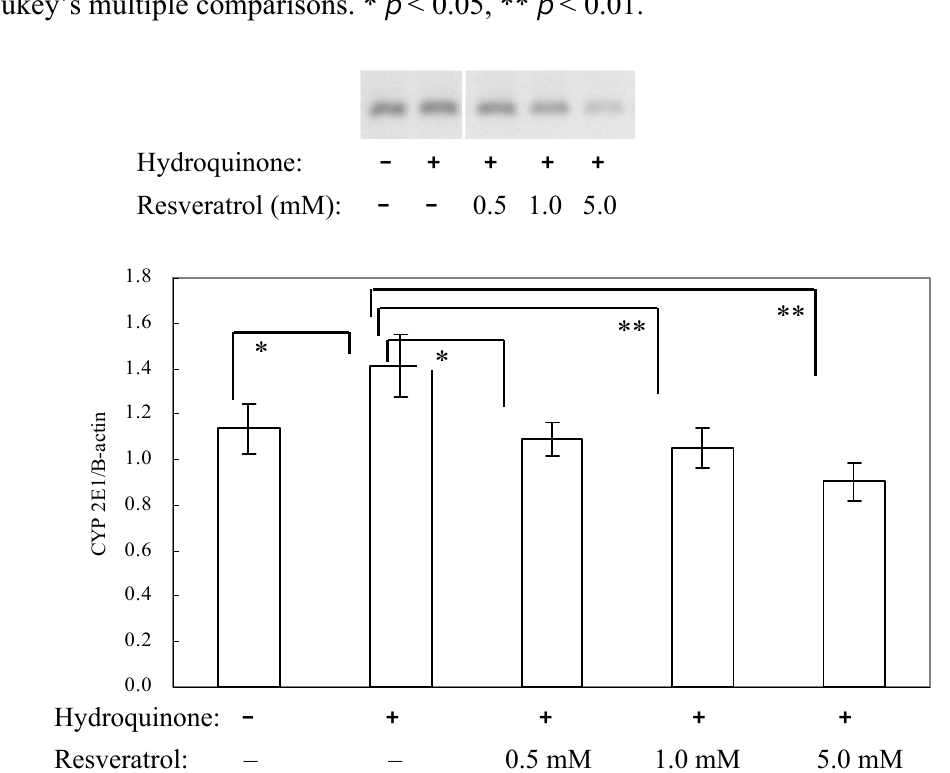
Figure 5. The effect of resveratrol on the expression of CYP2E1 mRNA in mouse primary hepatocytes exposed to hydroquinone. ( a ) Comparison of the expression of CYP2E1 mRNA among each treatment groups. ( b ) Comparison of the ratio of CYP2E1/ β -actin mRNA among each treatment groups. Data were analyzed by one-way ANOVA followed by Tukey’s multiple comparisons. * p < 0.05, ** p <